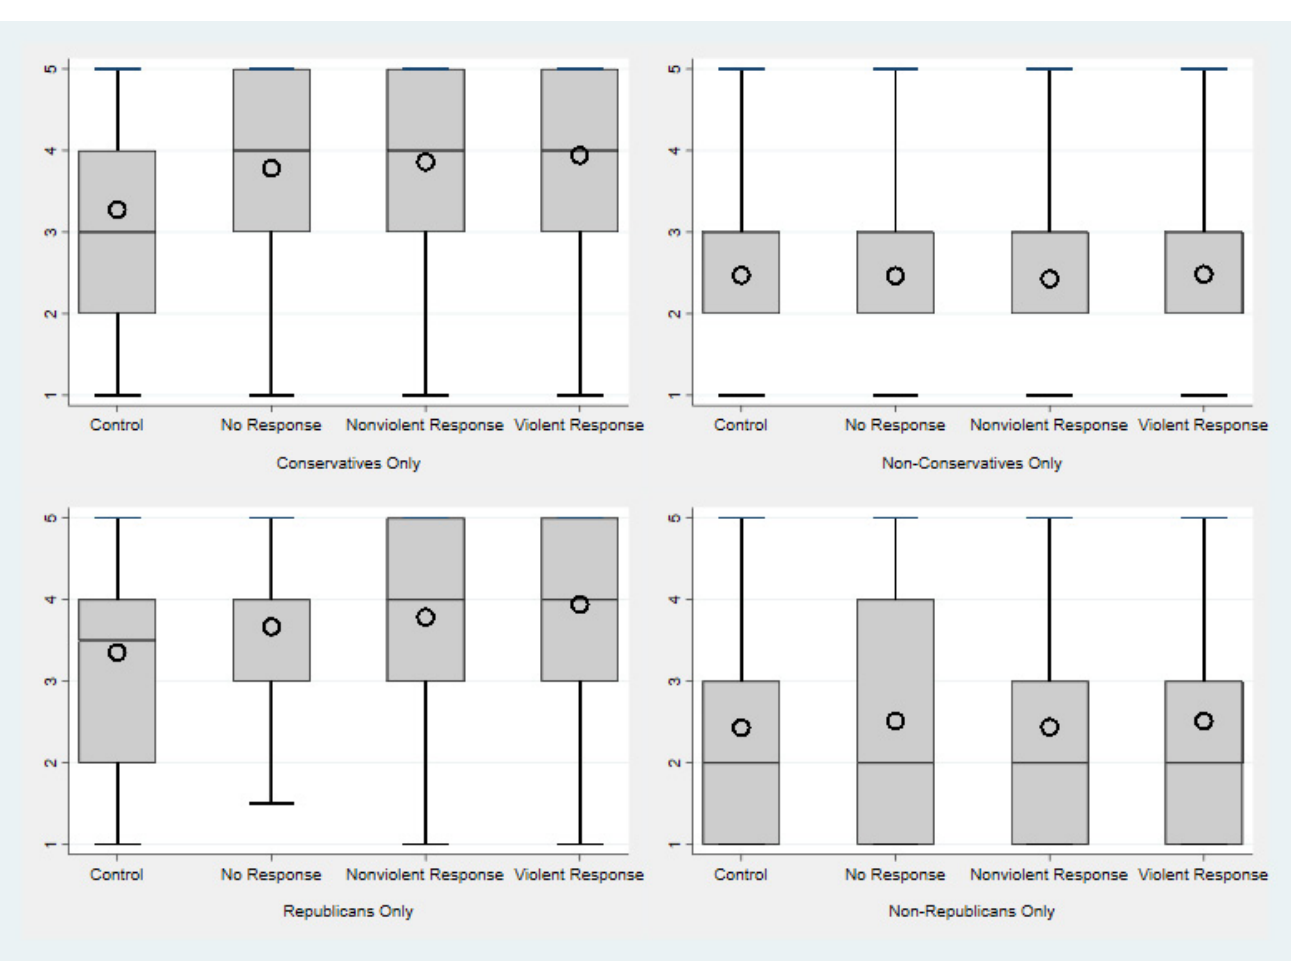
Figure 2. The causal effects of persecution discourse on perceptions of threat to religious liberty across conditions and by political subsample. The top left panel illustrates the effects of persecution discourse on the conservative subsample’s perceptions of threat to religious liberty. For comparison, the top right panel illustrates the effects of persecution discourse on the non-conservative (i.e., liberal and other) subsample’s perceptions of threat to religious liberty. The bottom left panel illustrates the effects of persecution discourse on the Republican subsample’s perceptions of threat to religious liberty. For comparison, the bottom right panel illustrates the effects of persecution discourse on the non-Republican (i.e., Democrat and other) subsample’s perceptions of threat to religious liberty. Key : boxes represent the interquartile range; circles represent the mean; thick lines represent the median; whiskers represent minimum and maximum values.